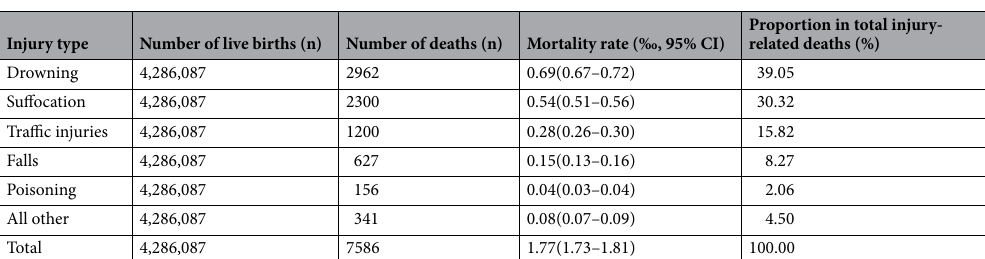
Table 2. Injury-related under-five mortality rate by injury type. CI confidence